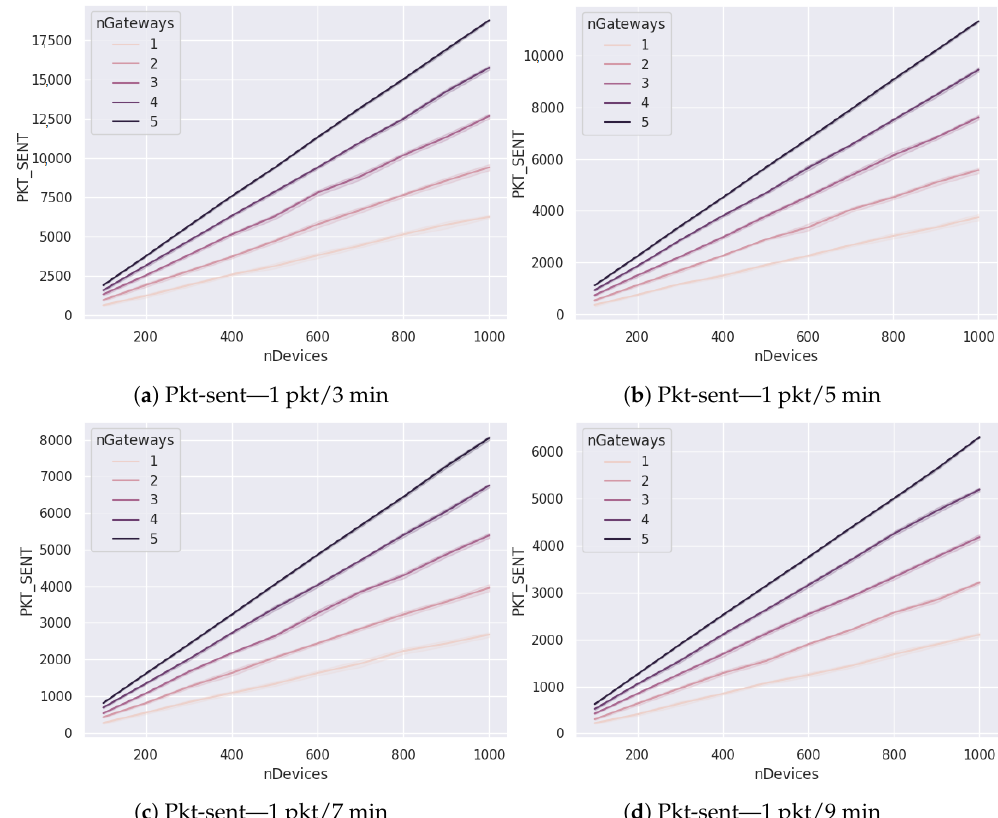
Figure 7. Pkt-sent results for a payload of 100 bytes while varying the number of gateways with a frequency of one packet every 3, 5, 7, and 9 min—unconfirmed